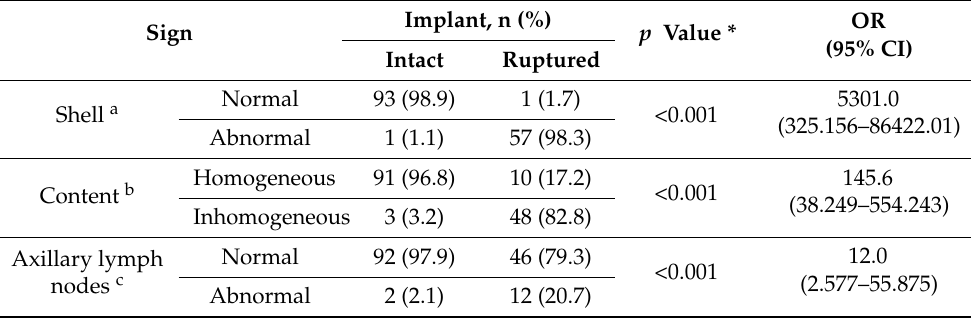
Table 3. Diagnostic signs of intact and ruptured implants on ultrasound.